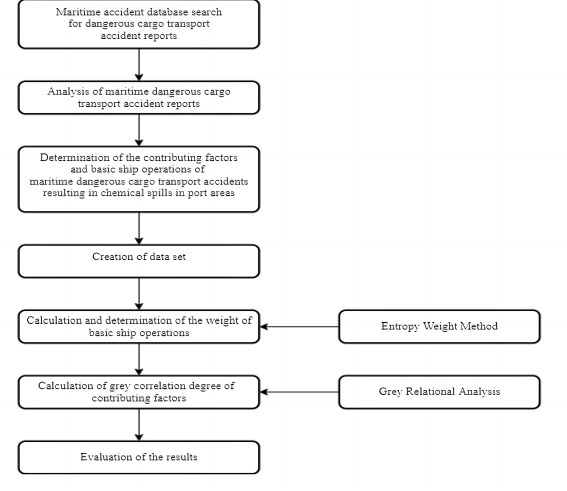
Fig. 1. The flowchart of the research